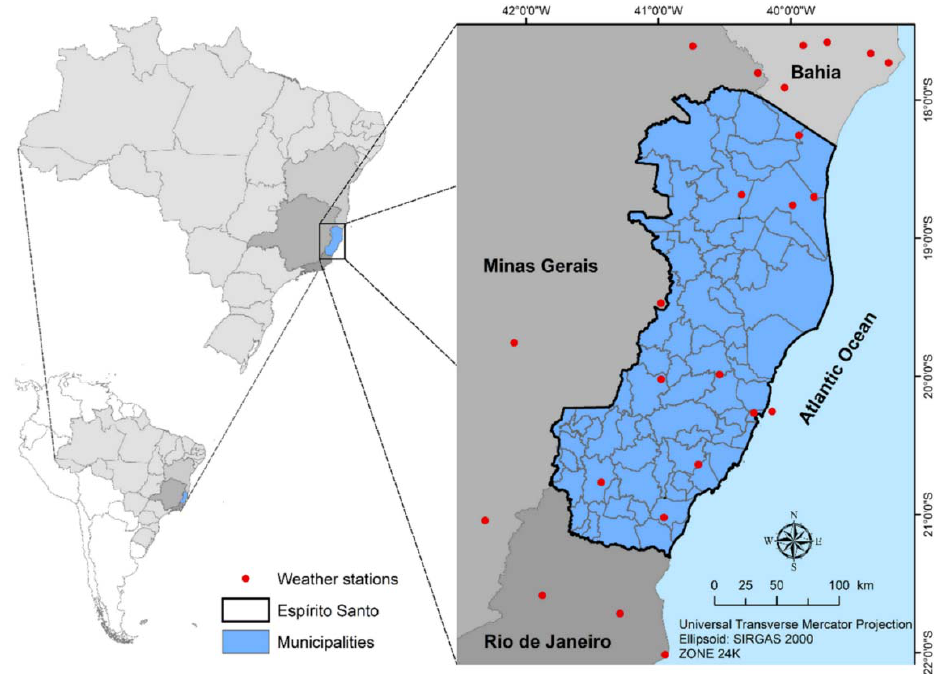
Figure 1. Study area and automatic meteorological stations are located in the state and neighboring areas.